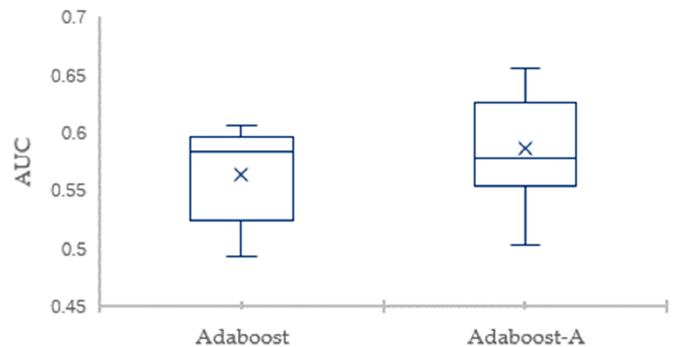
Figure 8. The AUC Comparison of AdaBoost and AdaBoost-A on KC1 Dataset.